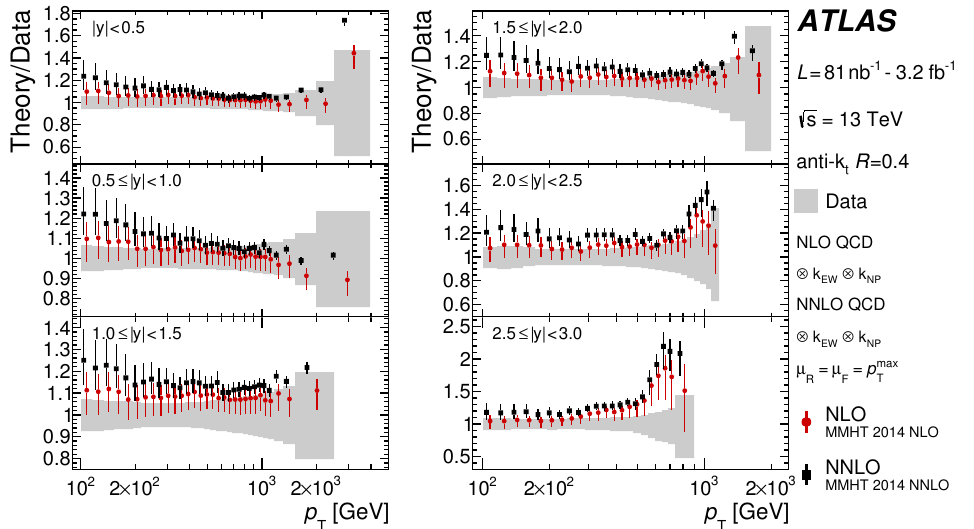
p [GeV] T Figure 12 . Ratios of the NLO and NNLO pQCD predictions to the measured inclusive jet cross- sections, shown as a function of the jet p T in six j y j bins for anti- k t jets with R = 0 : 4. The NLO predictions are calculated using NLOJET++ with the MMHT 2014 NLO PDF set. The NNLO predictions are provided by the authors of refs. [17, 18] using NNLOJET with p max as the QCD scale T and the MMHT 2014 NNLO PDF set. Non-perturbative and electroweak corrections are applied to the predictions. The NLO and NNLO uncertainties are shown by the coloured lines, including all the uncertainties discussed in section 9. The grey bands show the total data uncertainty including both the systematic (JES, JER, unfolding, jet cleaning, luminosity) and statistical uncertainties.